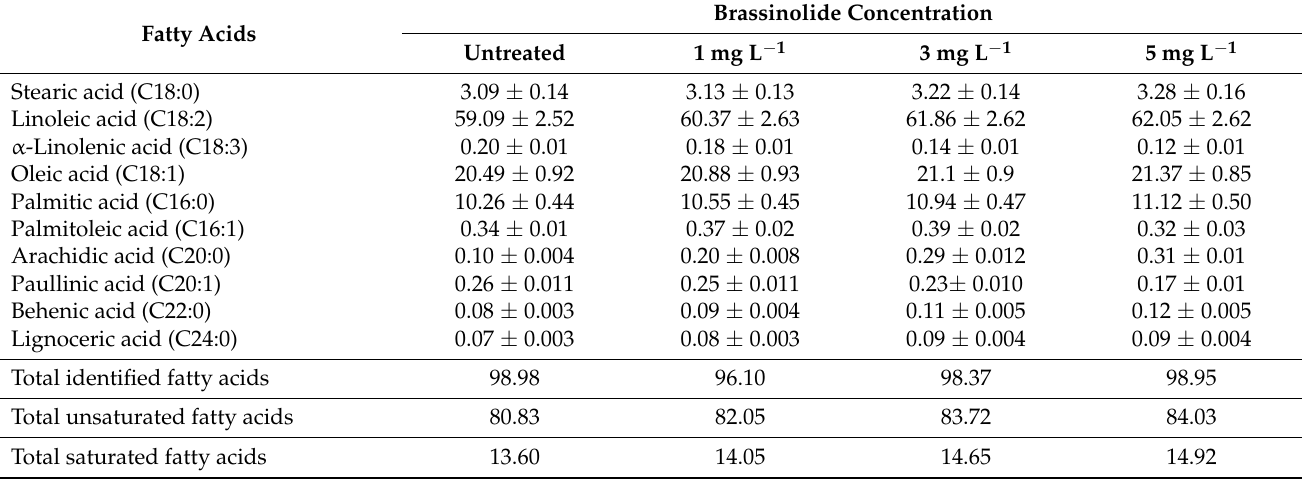
Figure 4. Oil (%), oil yield content (L plant − 1 ), and oil yield (L ha − 1 ) of Opuntia ficus-indica L. plant subjected to brassinolide foliar spray. Data are mean value ± SE. Bars with the same letters (lowercase for the first season and uppercase for the second season) are not significant at p ≤ 0.05 level. Table 2. GC–mass spectrometry analysis of Opuntia ficus-indica L. oil as affected by brassinolide foliar application.